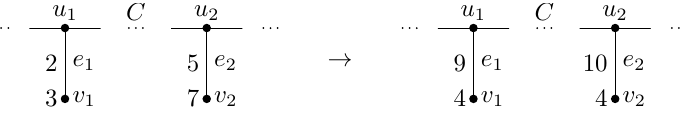
Figure 2: Recoloring of edges e